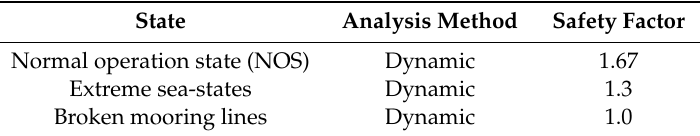
Table 4. Requirements of the minimum safety factors [35].